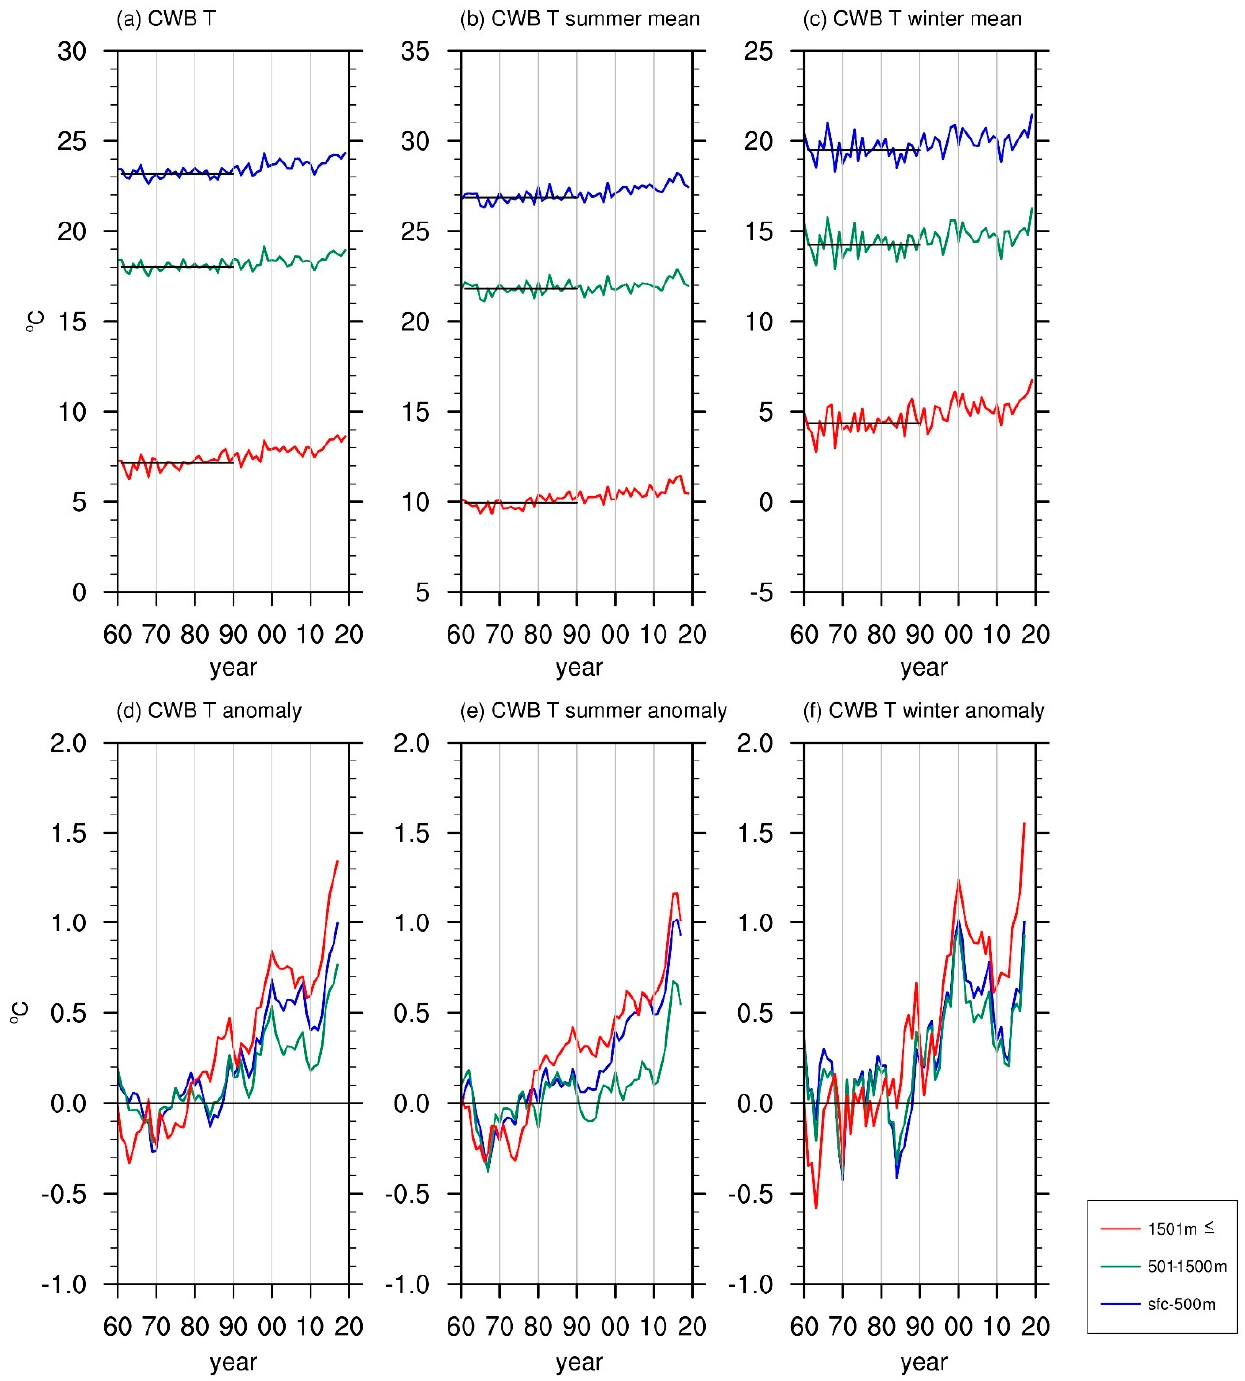
Figure 1. Interannual variations of the ( a ) annual mean, ( b ) summer mean, ( c ) winter mean temperatures based on the CWB conventional weather stations in various groups of altitudes (blue: the surface to 500 m; green: 501 m to 1500 m; red: above 1501 m), unit: °C. ( d – f ) are same as ( a – c ) but for the anomaly (applying five-year running mean). The 30-year period of 1961 to 1990 is averaged to produce a mean for the anomaly.